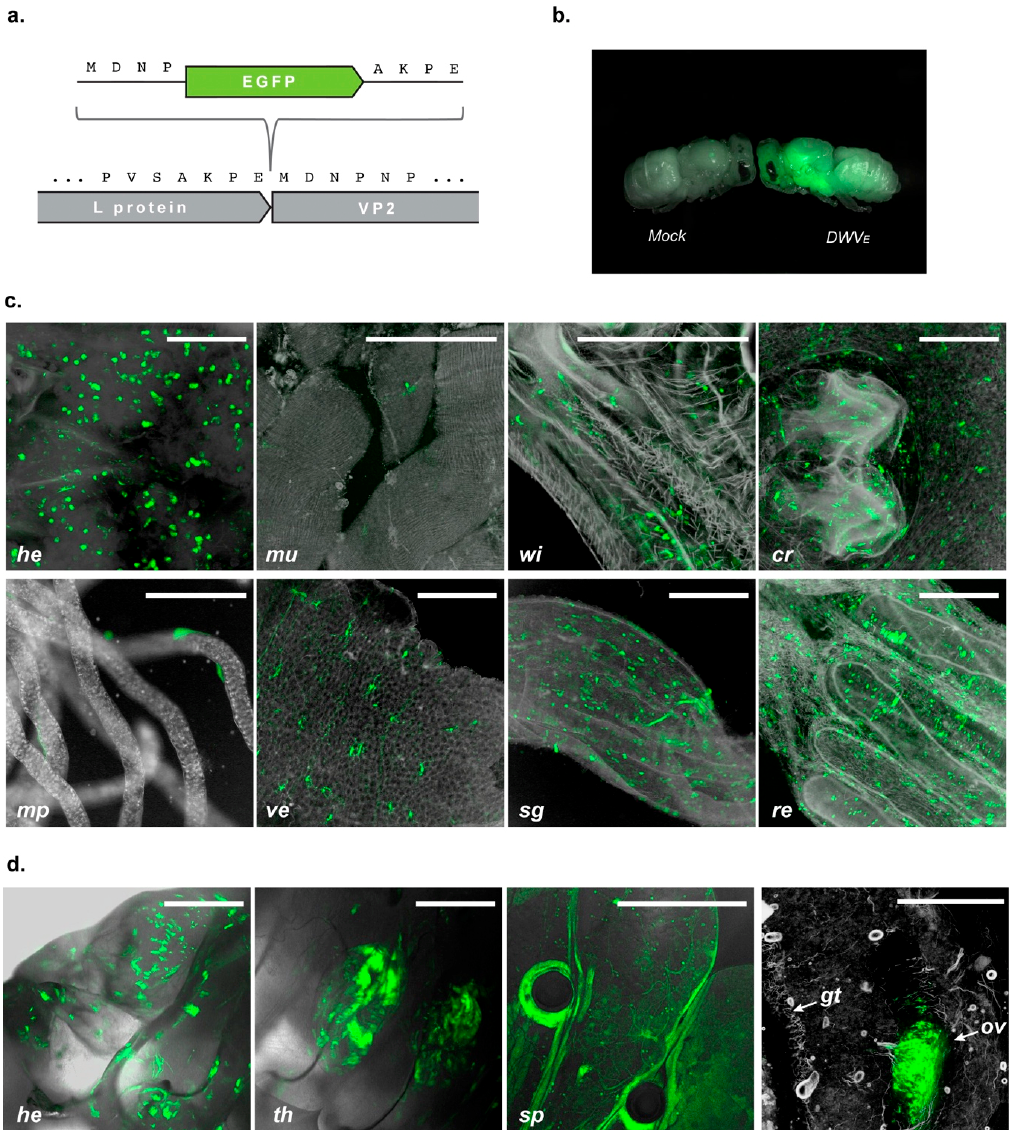
Figure 5. Localization analysis of the DWV-produced EGFP signal in infected honey bee brood. ( a ) Schematic representation of DWV E RG construct design; only part of the viral genome, where the insert was placed, is shown; amino acid sequences are presented using single-letter code. ( b ) Combined image of fluorescent and white-field photo showing not-injected (“Mock”) and DWV E injected pupae. ( c ) Confocal microscopy analysis of EGFP signal localisation in DWV E infected honey bee pupae 22 h post-inoculation: dorsal side of the head with removed cuticle (“he”), thorax muscles (“mu”), wing rudiment (“wi”), crop (“cr”), Malpighian tubules (“mp”), ventriculus (“ve”), small gut (“sg”), and rectum (“re”); composite of fluorescent signal z-stack and inverted white-field image are shown for convenience of interpretation; scale bars correspond to 500 μ m on all panels except “mp”, where 200 μ m is shown. ( d ) Confocal microscopy analysis of living larva (first three panels) and cryosection of infected larva (right panel) sampled 6 days after feeding with 5*10 7 GE of DWV E inoculate: head (“he”), wing rudiments in thoracic segments (“th”), spiracle openings (“sp”), sagittal section of larva showing rudimental ovary (“ov”) and part of the midgut wall (“gt”); composite of fluorescent signal z-stack and white-field image (inverted on the cryosection panel) are shown; scale bars correspond to 500 μ m.